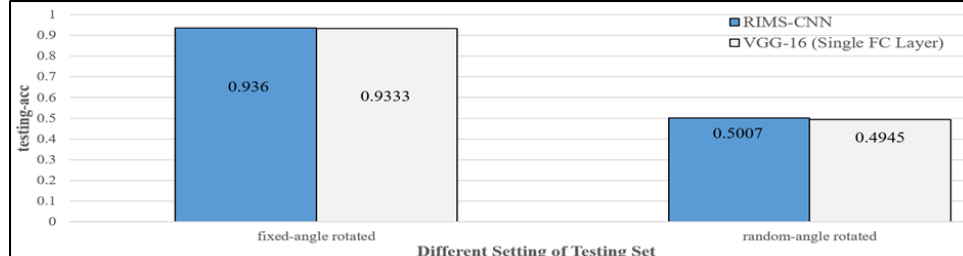
Figure 29. Evaluating RIMS-CNN and VGG-16 on the fixed-angle and random-angle rotated FASH- ION-MNIST.